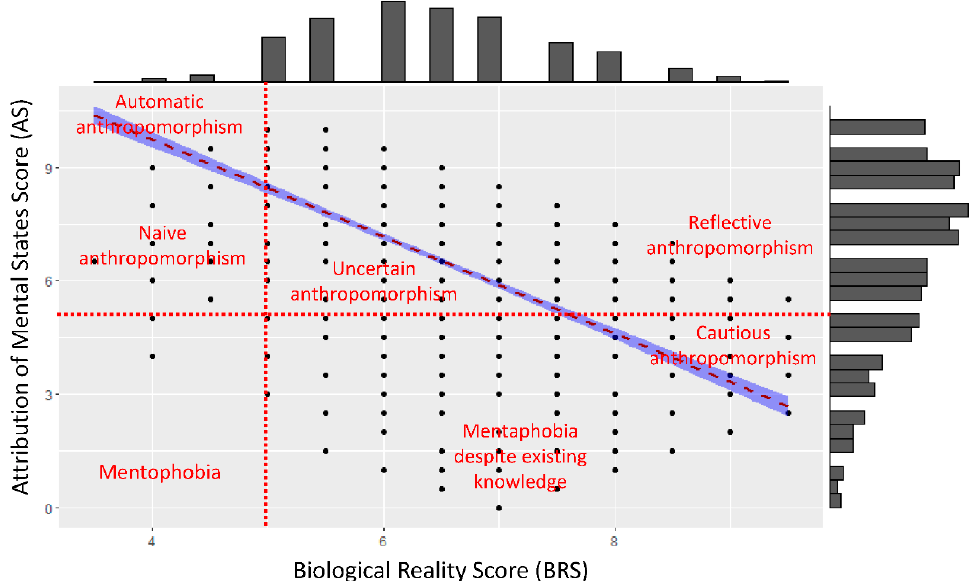
Figure 3. Frequency distribution (histograms) for the Attribution of Mental States Score (AS_TOTAL, y) and the Biological Reality Score (BRS_TOTAL, x). The red dashed line indicates the regression line between the two distributions, with the confidence interval in blue. According to this regression line and the middle score (i.e., 5) for AS and BRS, we divided the figure into different parts indicating anthropomorphism: from mentaphobia to automatic anthropomorphism to reflective (or critical) anthropomorphism.